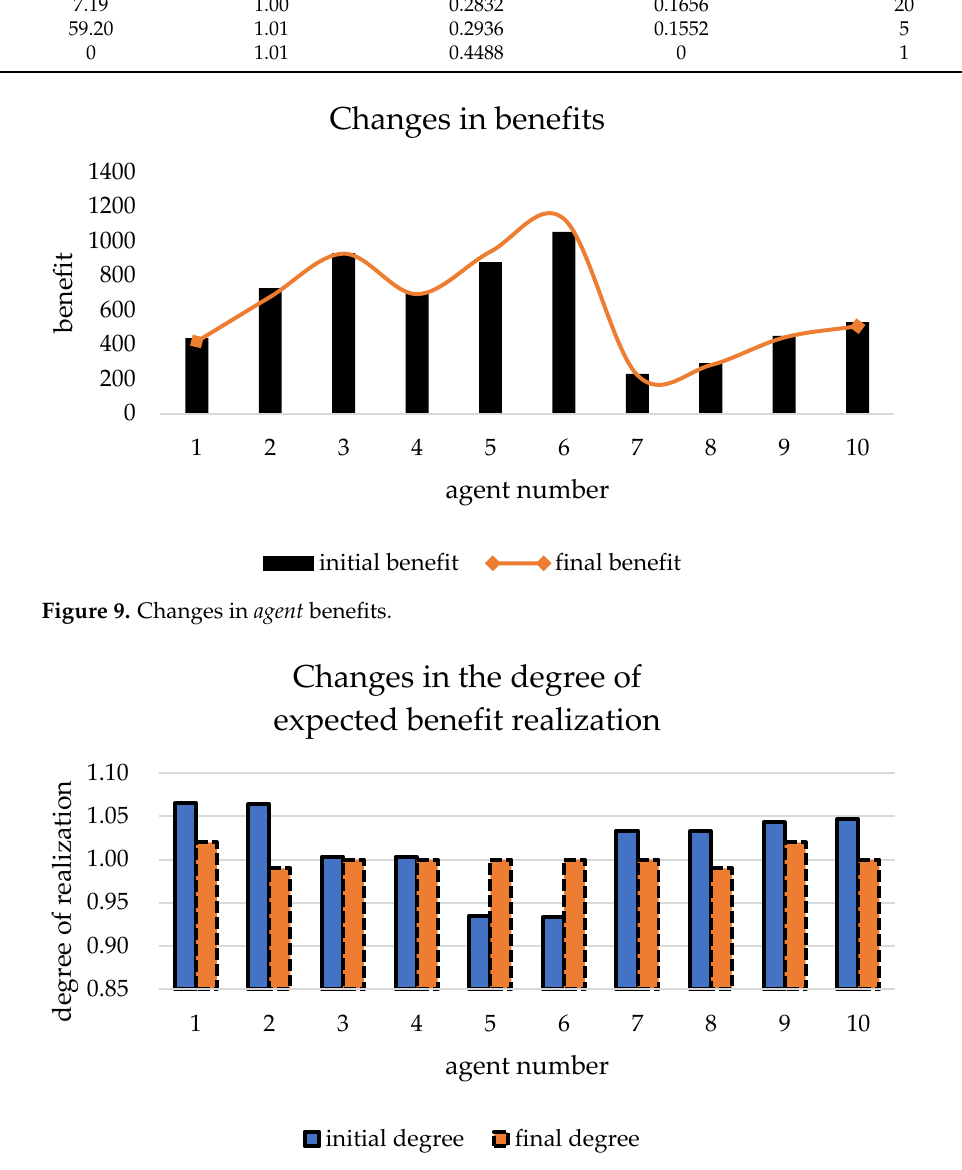
Figure 10. Changes in agent realization.